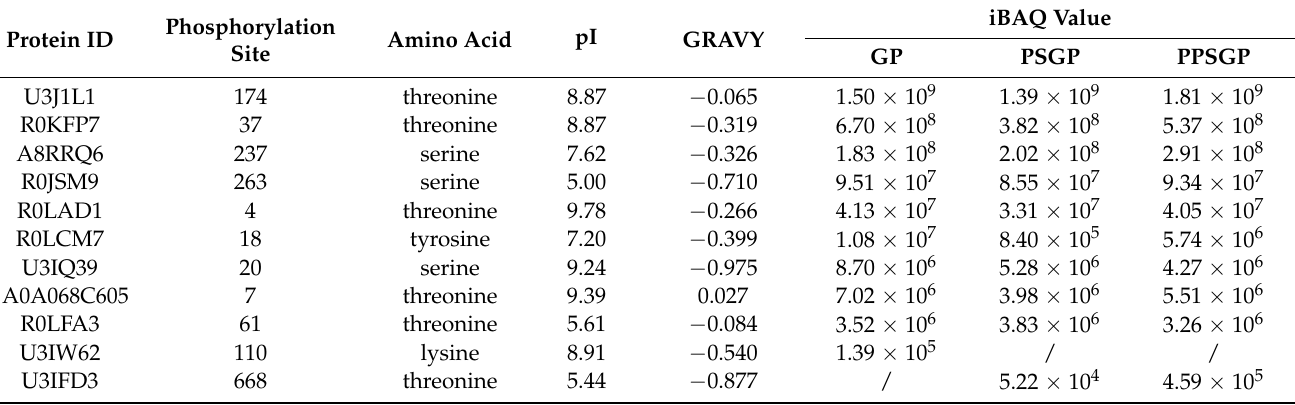
Table 5. Analysis of phosphorylated